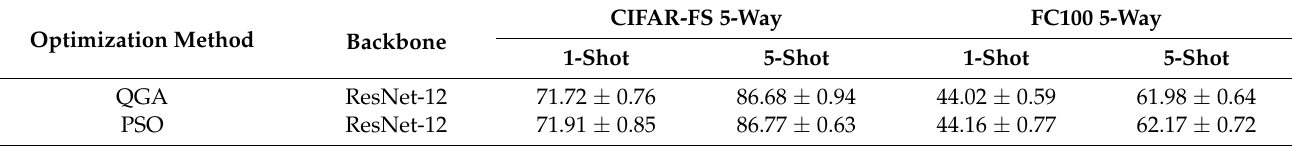
Table 10. Meta-learning accuracy of different optimization methods on CIFAR-FS and FC100. Optimization